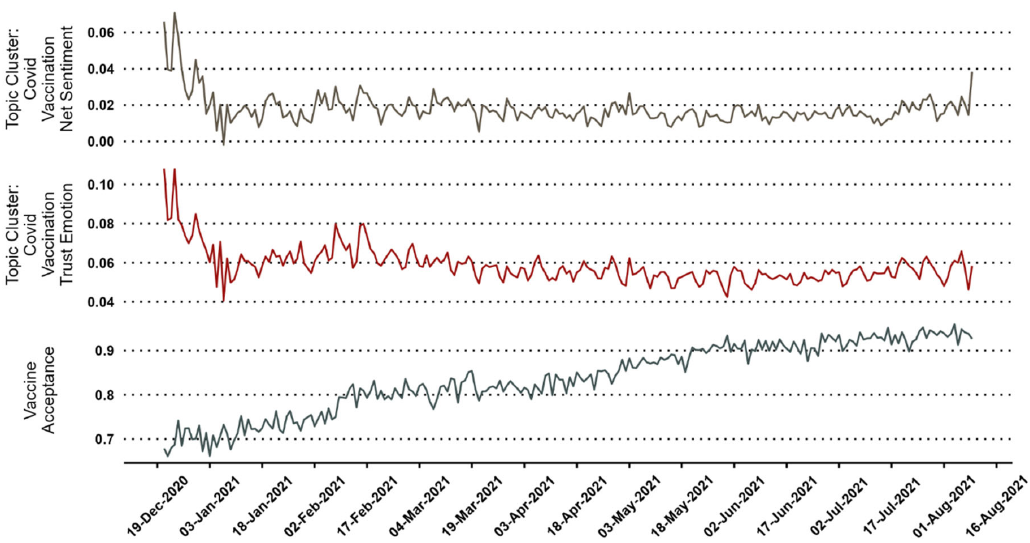
Figure 2. Trust, net sentiment, and vaccine acceptance from December 2020 to August 2021.